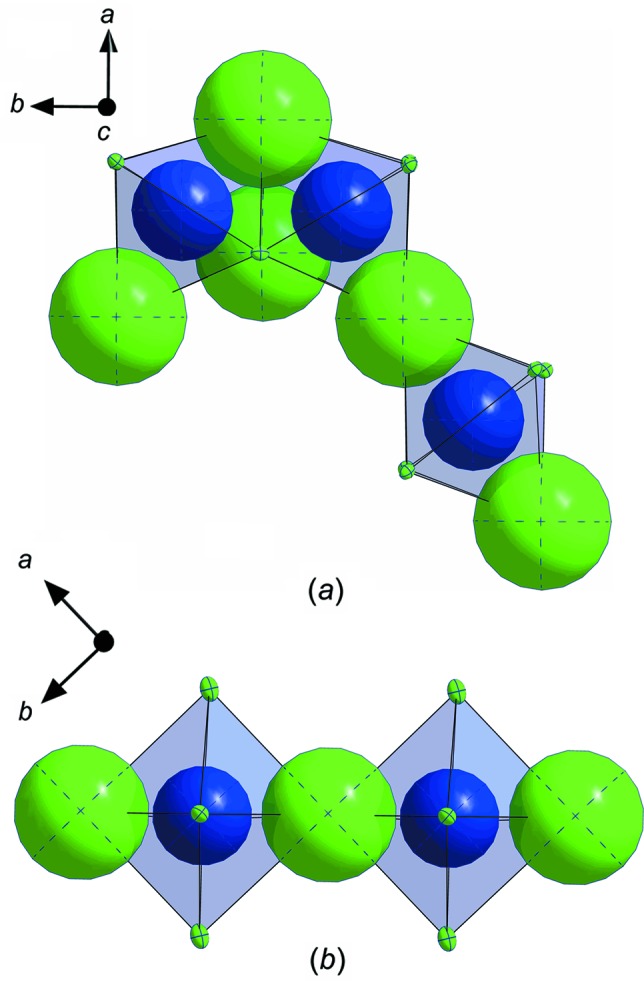
Comparison of the K–Cl octa­hedra and their connectivity in (a) ortho­rhom­bic and (b) monoclinic KCl·MgCl2·6H2O. Colour key: K blue and Cl green.